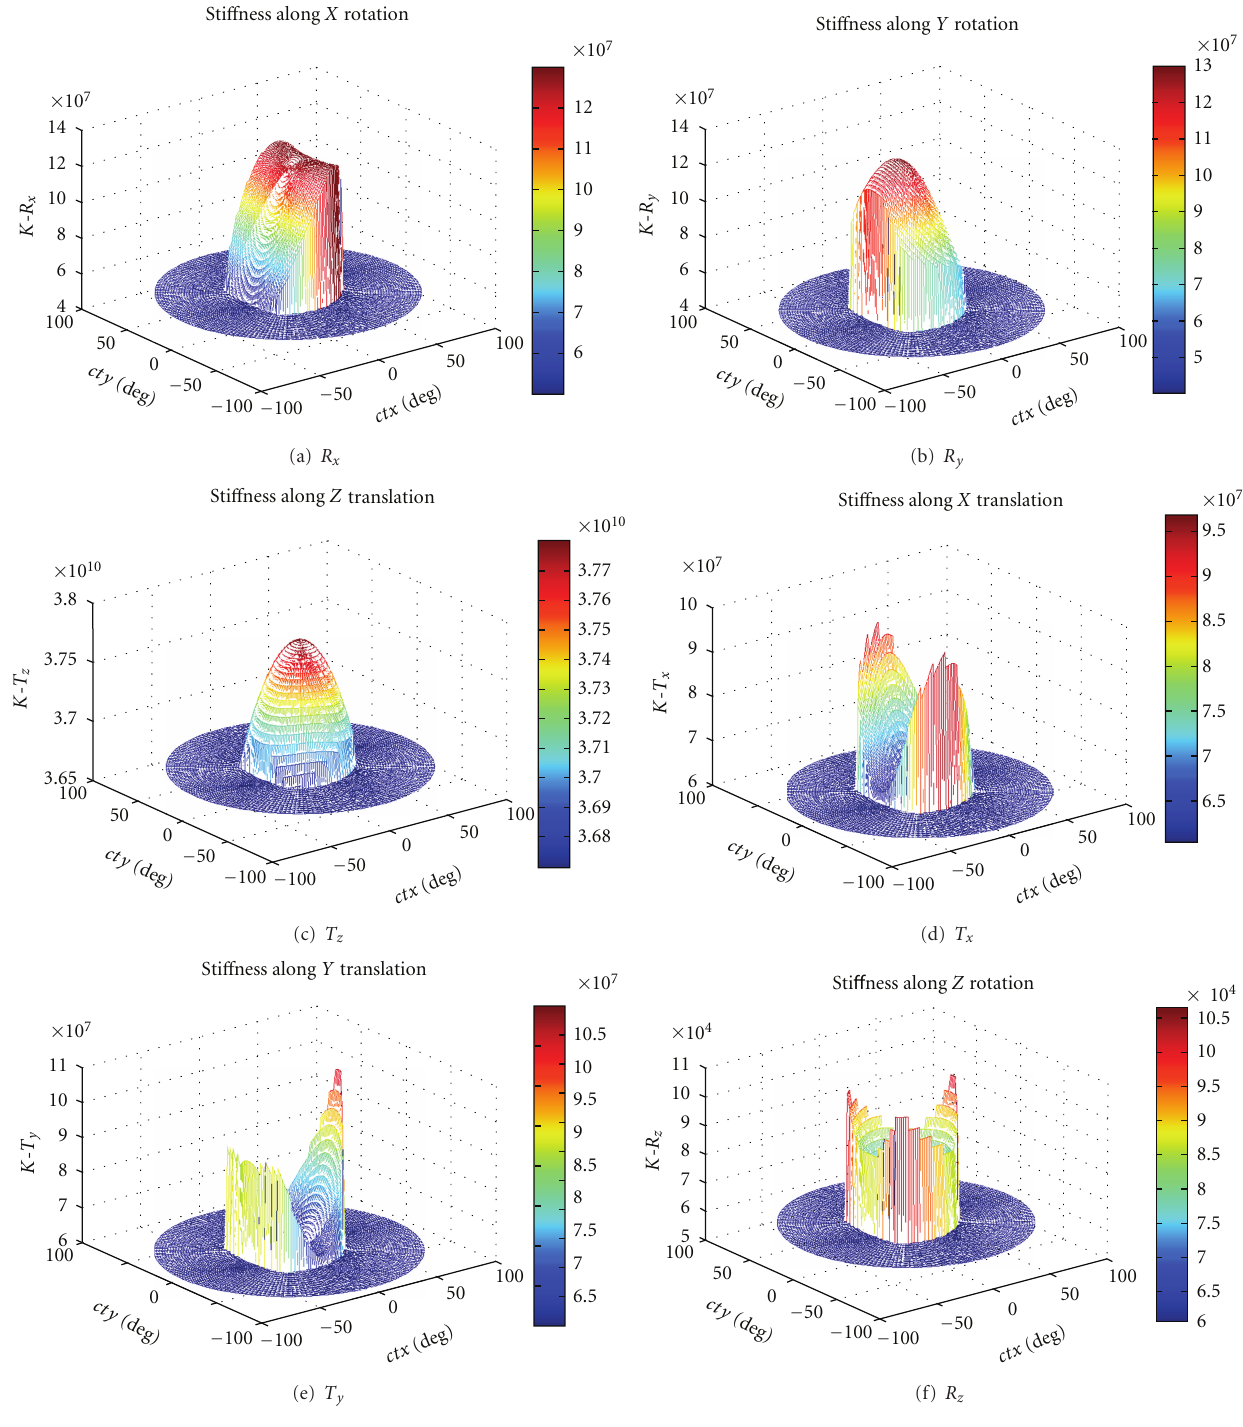
Figure 4: Sti ff ness over the middle cross-section of task